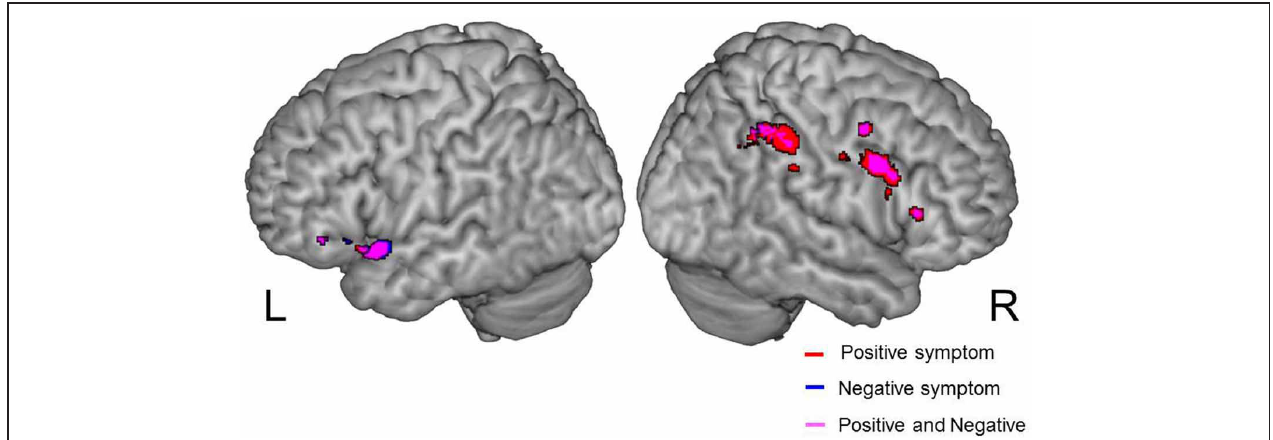
FIGURE 6 | Positive correlation between psychiatric symptom and cerebral activation under FJT > GDT contrast (univariate analysis). Positive symptom is red color, Negative symptom is blue color. Purple color indicates both symptoms. Statistical threshold: p < 0 . 25, FDR-corrected; L, left; R, right side.